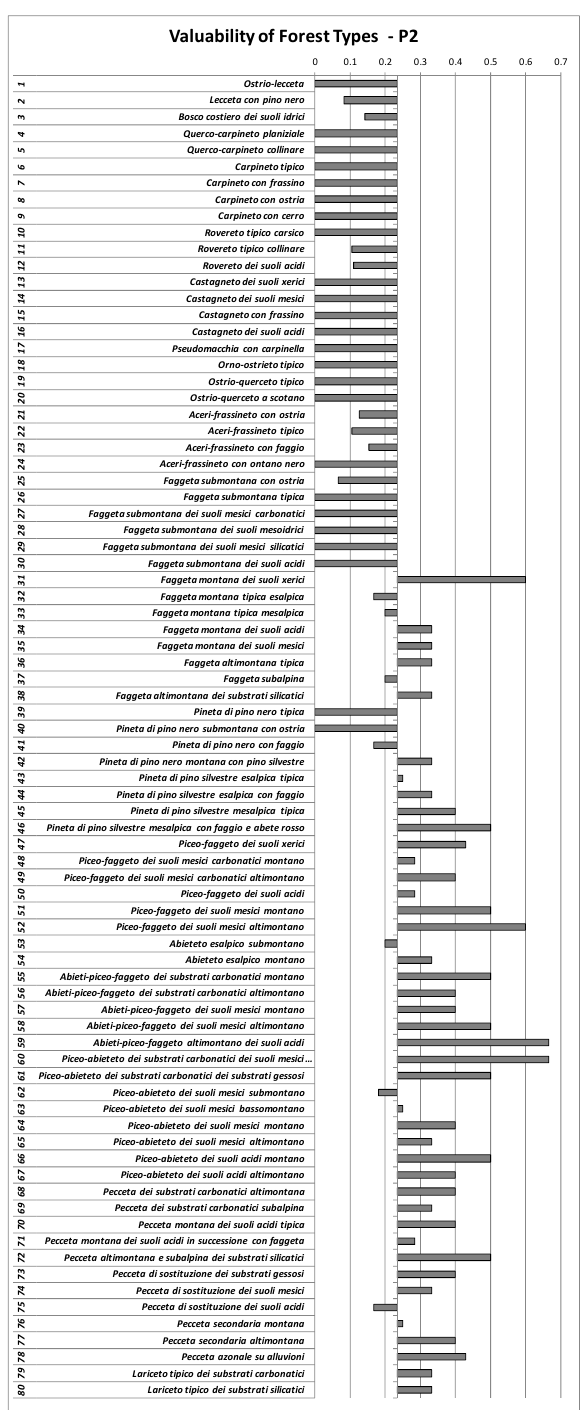
Figure A2. Forest types by increasing altitude. Average P2 value: 0.233409. Below-average = 0; Above-average = 1. Source: authors.